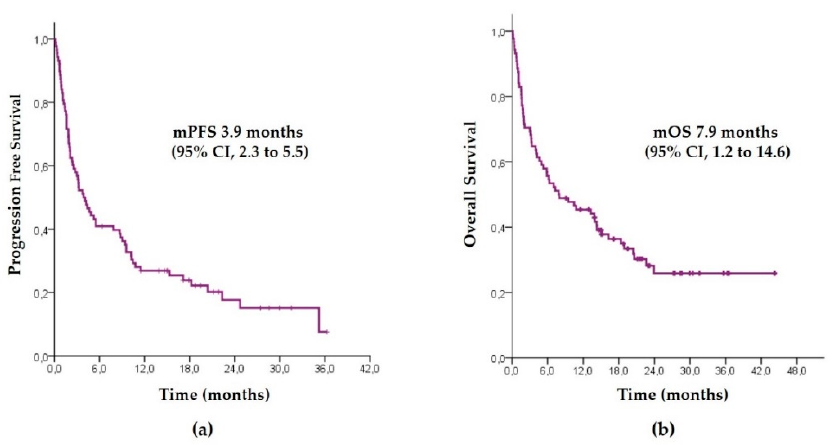
Figure 1. Estimation of probability of progression-free survival ( a ) and overall survival ( b ) through Kaplan–Meier curves in overall population. mPFS (median Progression Free Survival); mOS (me- dian Overall Survival).